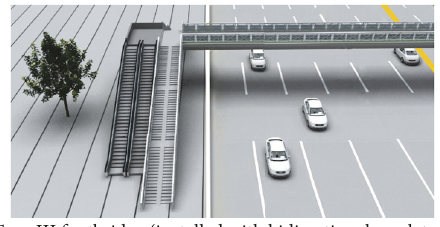
Figure 1: Type I, type II, and type III